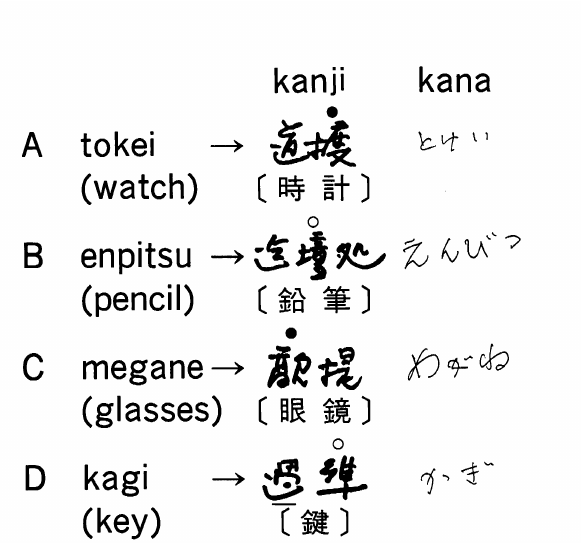
FIG. 2. Neologistic kanji or kanji-like words in writing to dictation. Words on the left side show the words spoken by examiners. In writing kanji, the patient wrote two or three neologistic character compounds, in which established kanji characters or kanji-like characters were meaninglessly or randomly spelled. The kanji-like characters consisted of random composition (e) or modification (0) of established kanji characters and their right- and left-hand radicals. The neologistic writing was morphologically irrelevant to the correct target kanji characters ([ D. Furthermore, the neologis tic writing was phonetically irrelevant to the spoken words, although the "phonetic use of kanji" peculiar to Gogi aphasia was rarely observed (the kanji character underlined in 0 can be pro nounced "ka" in on-reading, corresponding to the first syllable in the dicated word). On the other hand, the patient could write kana correctly and